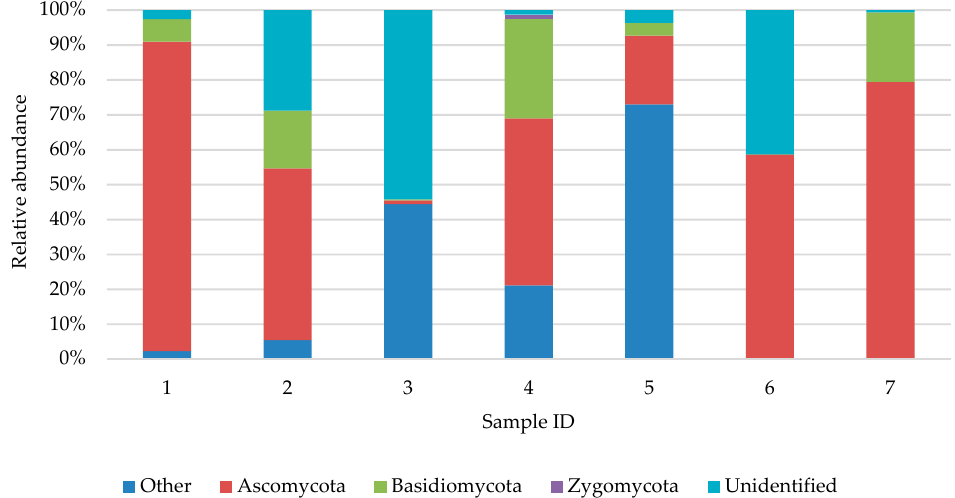
Figure 10. Biodiversity of fungi in samples acquired from feet skin of examined people. 1—man, 0–10